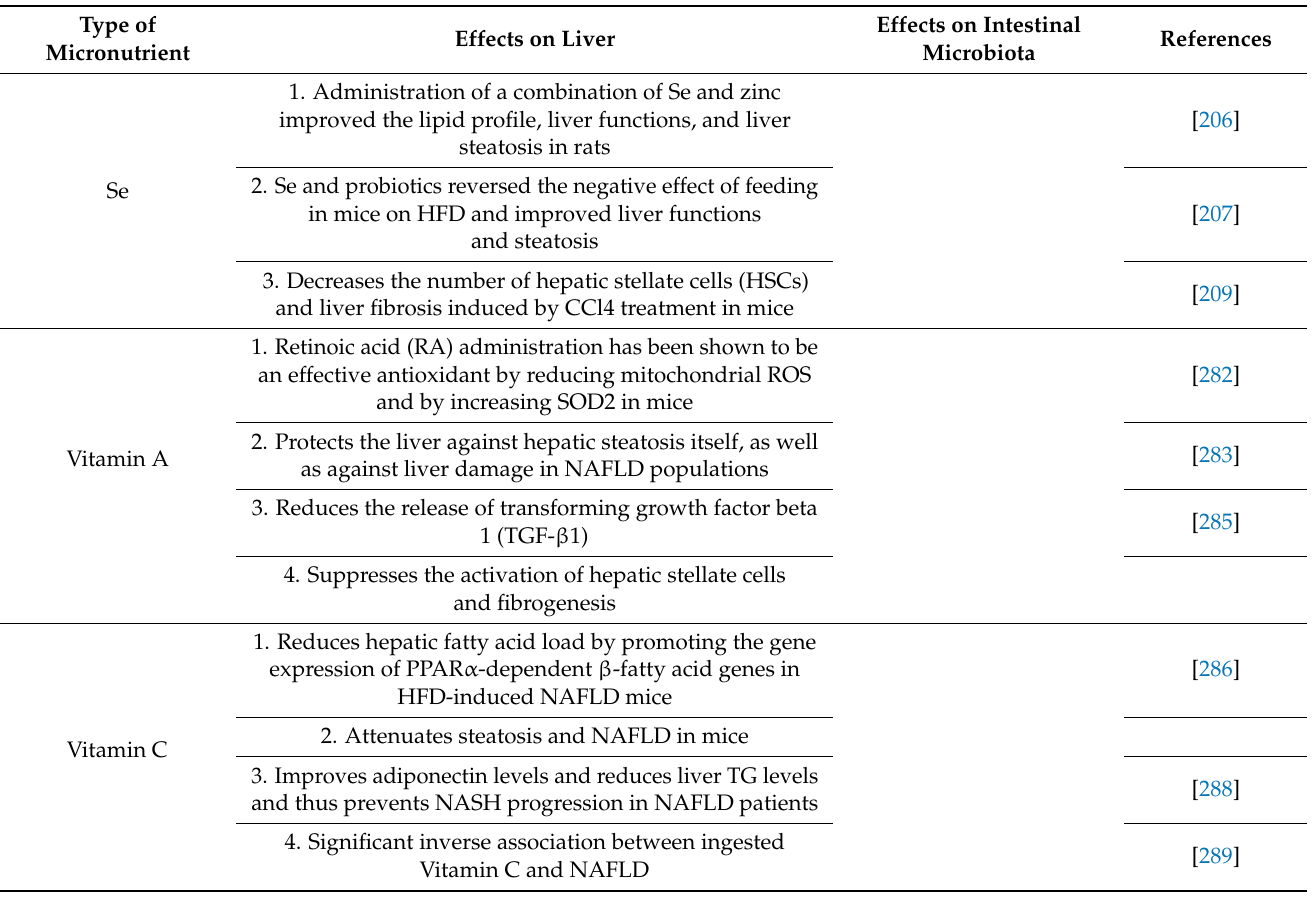
Table 3. Impact of micronutrients on